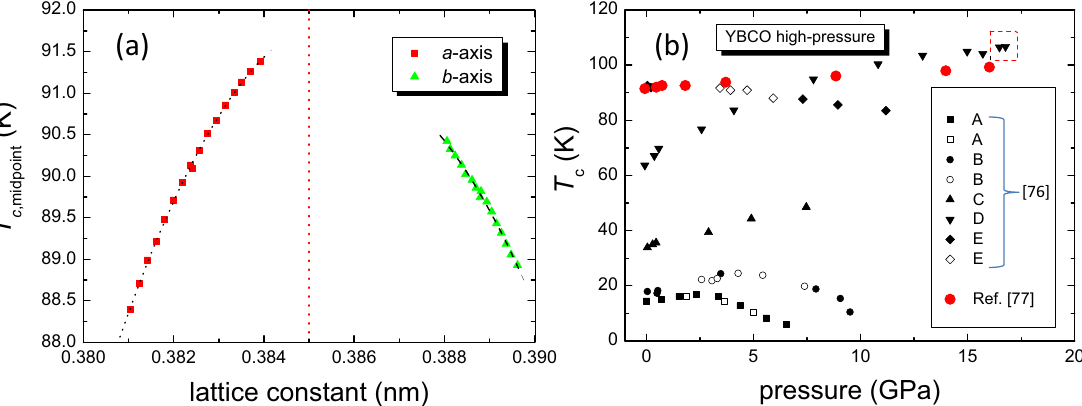
Figure 8. ( a ) Relationship between T c and the lattice constants at room temperature, redrawn from Ref. [37]. The dashed red line indicates the optimum condition for the highest T c with a = b = 0.385 nm. The dotted and dashed lines are polynomal fits to the data. ( b ) shows the effect of applying pressure to various YBCO crystals (experimental runs A–E, see main text, taken from Ref. [76]). Closed symbols are for increasing pressure, open symbols are for decreasing pressure. The red bullets ( • ) indicate data from Ref. [77]. The record T c obtained in the YBCO system was found to be 106.7 K (indicated by a dashed-red box) at 17